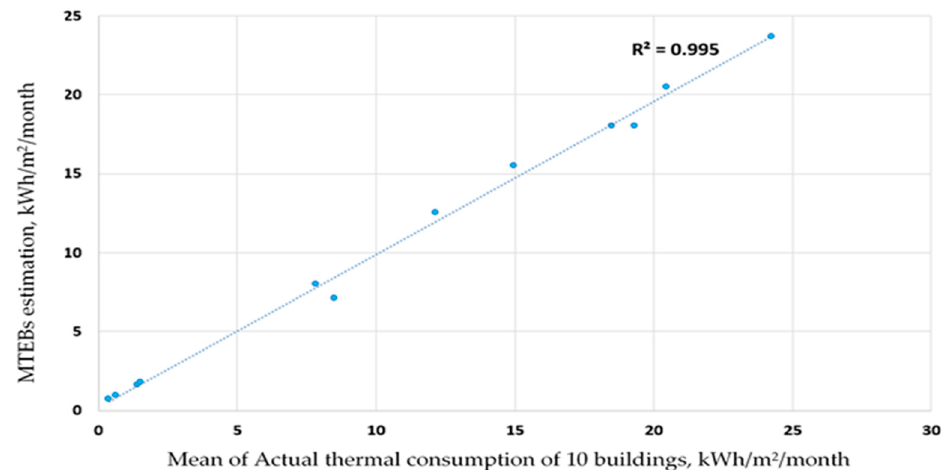
Figure 8. Accuracy assessment of the MTEBs.